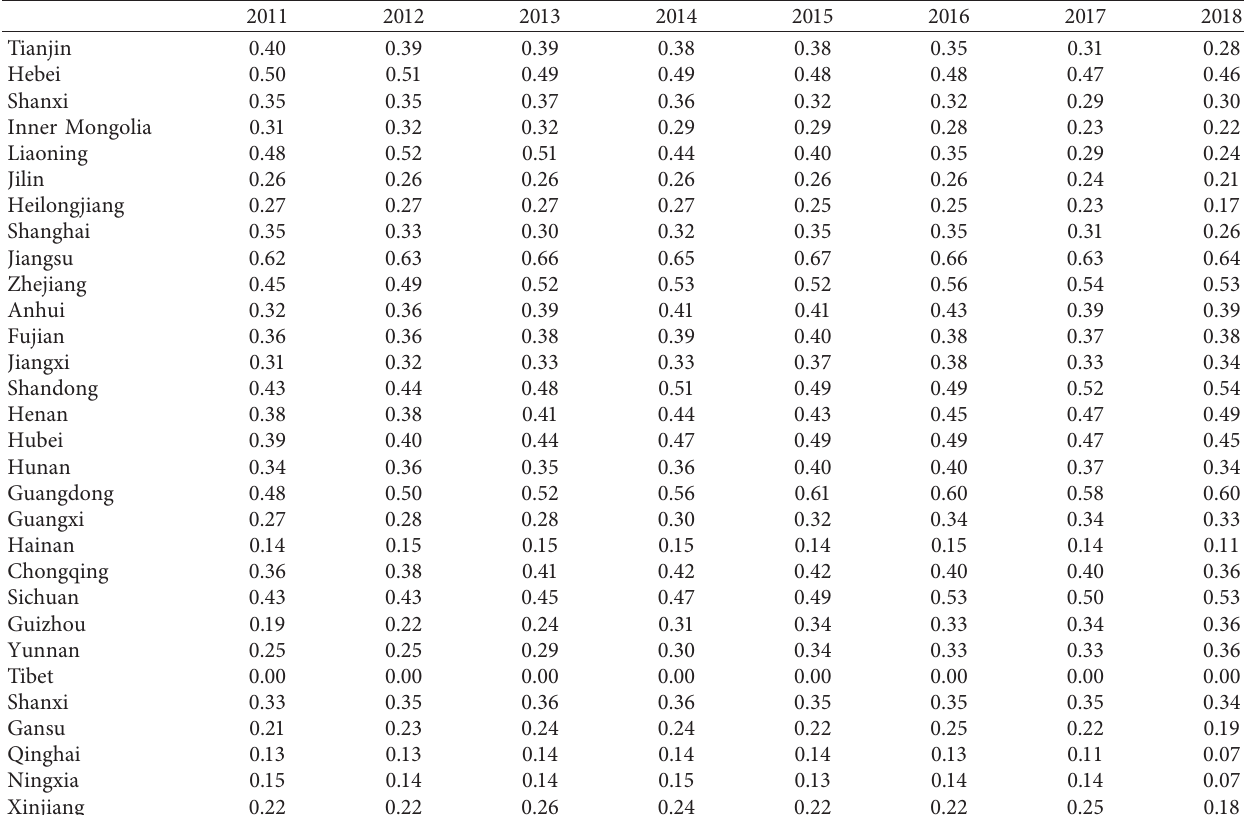
Figure 5: Fluctuation trend of influence degree of the construction industry in abnormal areas. Table 3: Coupling degree of the construction output value in 30 provinces of China (except